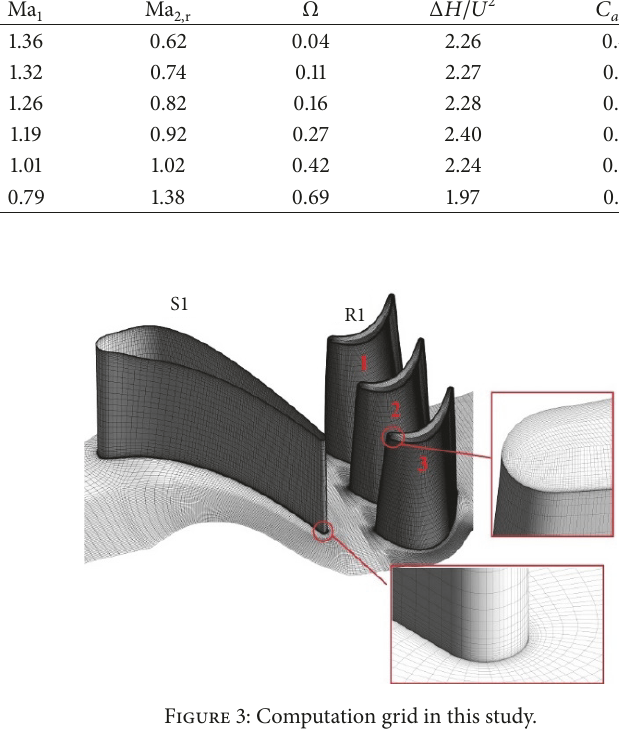
The grid independency check is conducted by unsteady simulation on the design (0 ∘ ) vane case at high pressure ratio condition with varying grid sizes ranging from 1.2 to 7.4 million nodes. The results of the grid independency check are shown in Figure